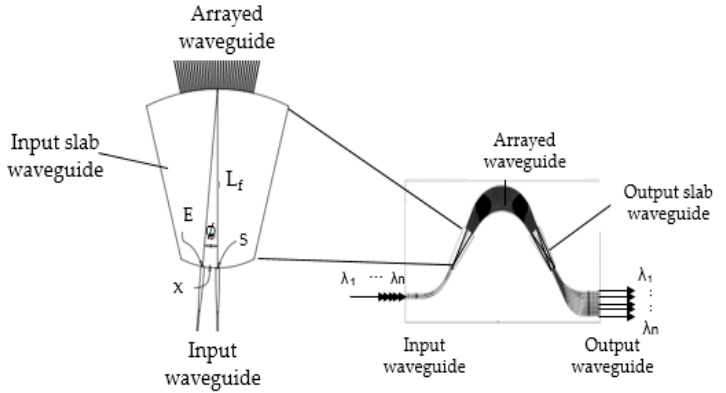
Figure 1. AWG’s input and output slab waveguide circuit structure [15].